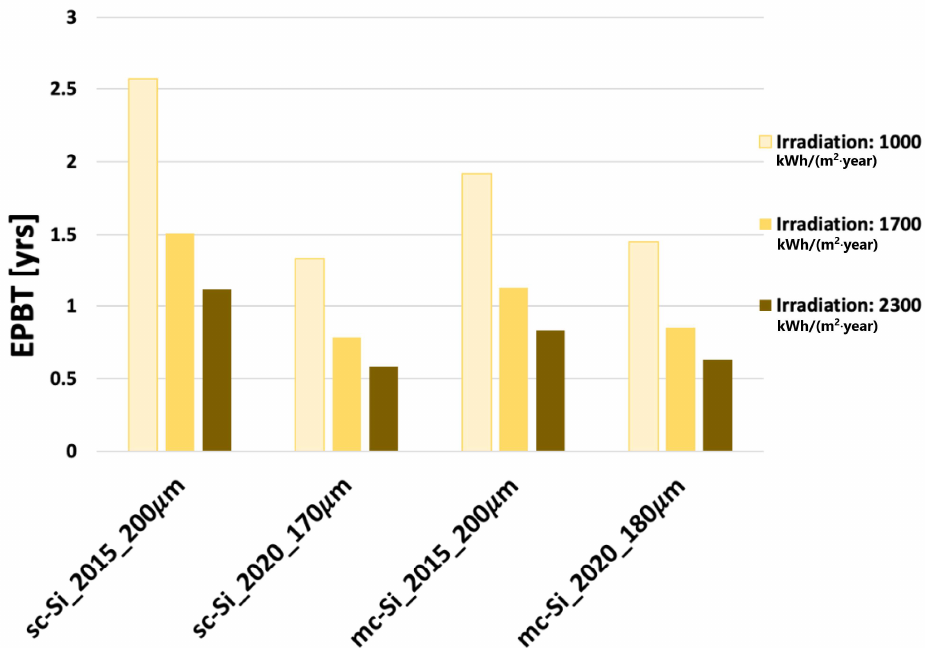
Figure 2. EPBTs reductions from 2015 to 2020, under three irradiation levels: 1000 kWh/(m 2 · year), 1700 kWh/(m 2 · year), and 2300 kWh/(m 2 · year). Performance ratio: 0.85. Efficiencies: 17% and 20.5% for 2015 and 2020 single-crystalline Si (sc-Si) photovoltaic (PV), respectively, and 16% and 18% for 2015 and 2020 multicrystalline Si (mc-Si) PV, respectively—from Fthenakis and Leccisi